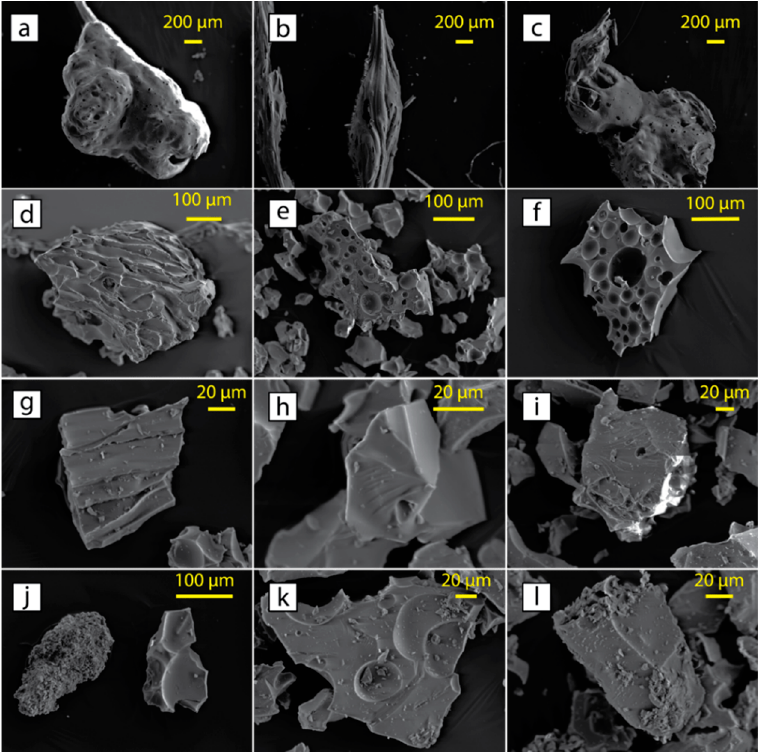
Figure 5. Surtsey ash-grains (from the Icelandic Natural History Museum samples collection, Table 1); shapes and microtextures. ( a ) Overview of BSE image of fine ash (3.0–3.5 Φ ) in a polished grain mount. ( b ) ‒ ( c ) Tachylite and ( d ) sideromelane.